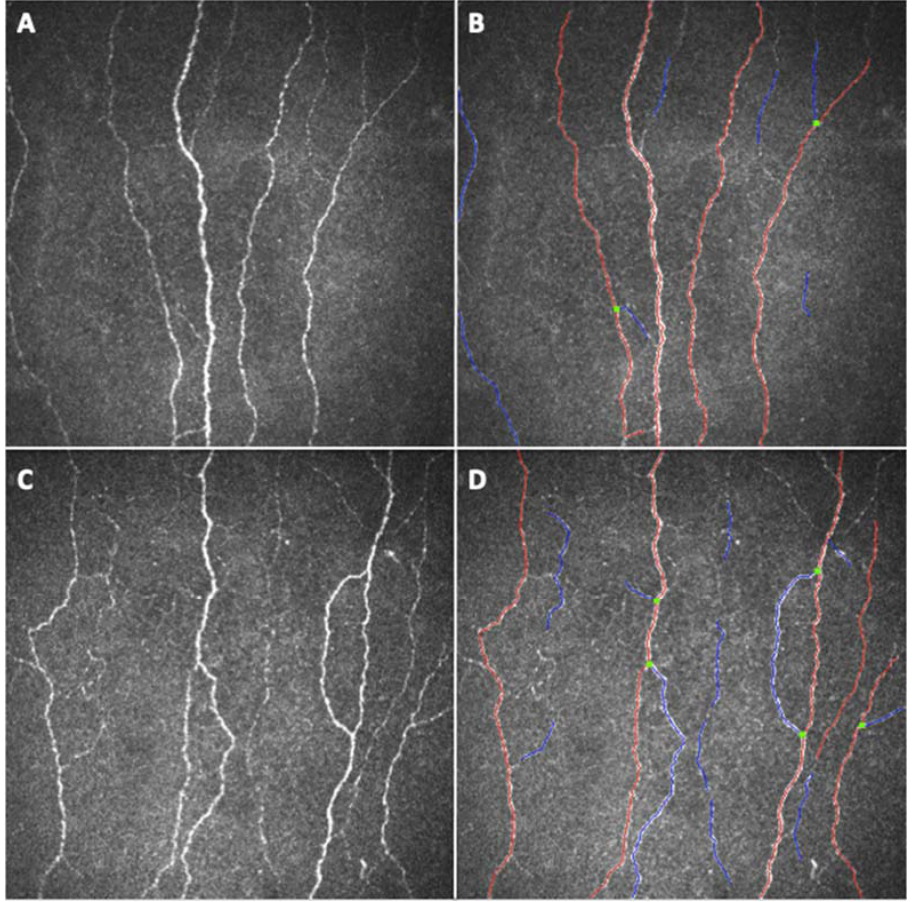
Figure 1. In-vivo corneal confocal microscopy images of the sub-basal nerve plexus of ( A ) a healthy subject and ( C ) a patient recovered from coronavirus disease 2019 (COVID-19) and their respective ACCMetrics analysis images ( B , D ), showing the main fibers in red, the branched fibers in blue and the branching points in green. ( B ) The ACCMetrics analysis of ( A ) compared to ( D ) the ACCMetrics analysis of ( C ) shows an increased number of branching points.